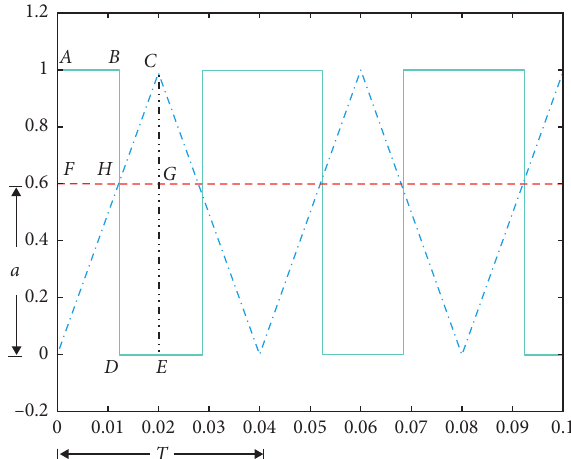
Figure 4: The pulse generated comparing μ � a with a triangular wave.